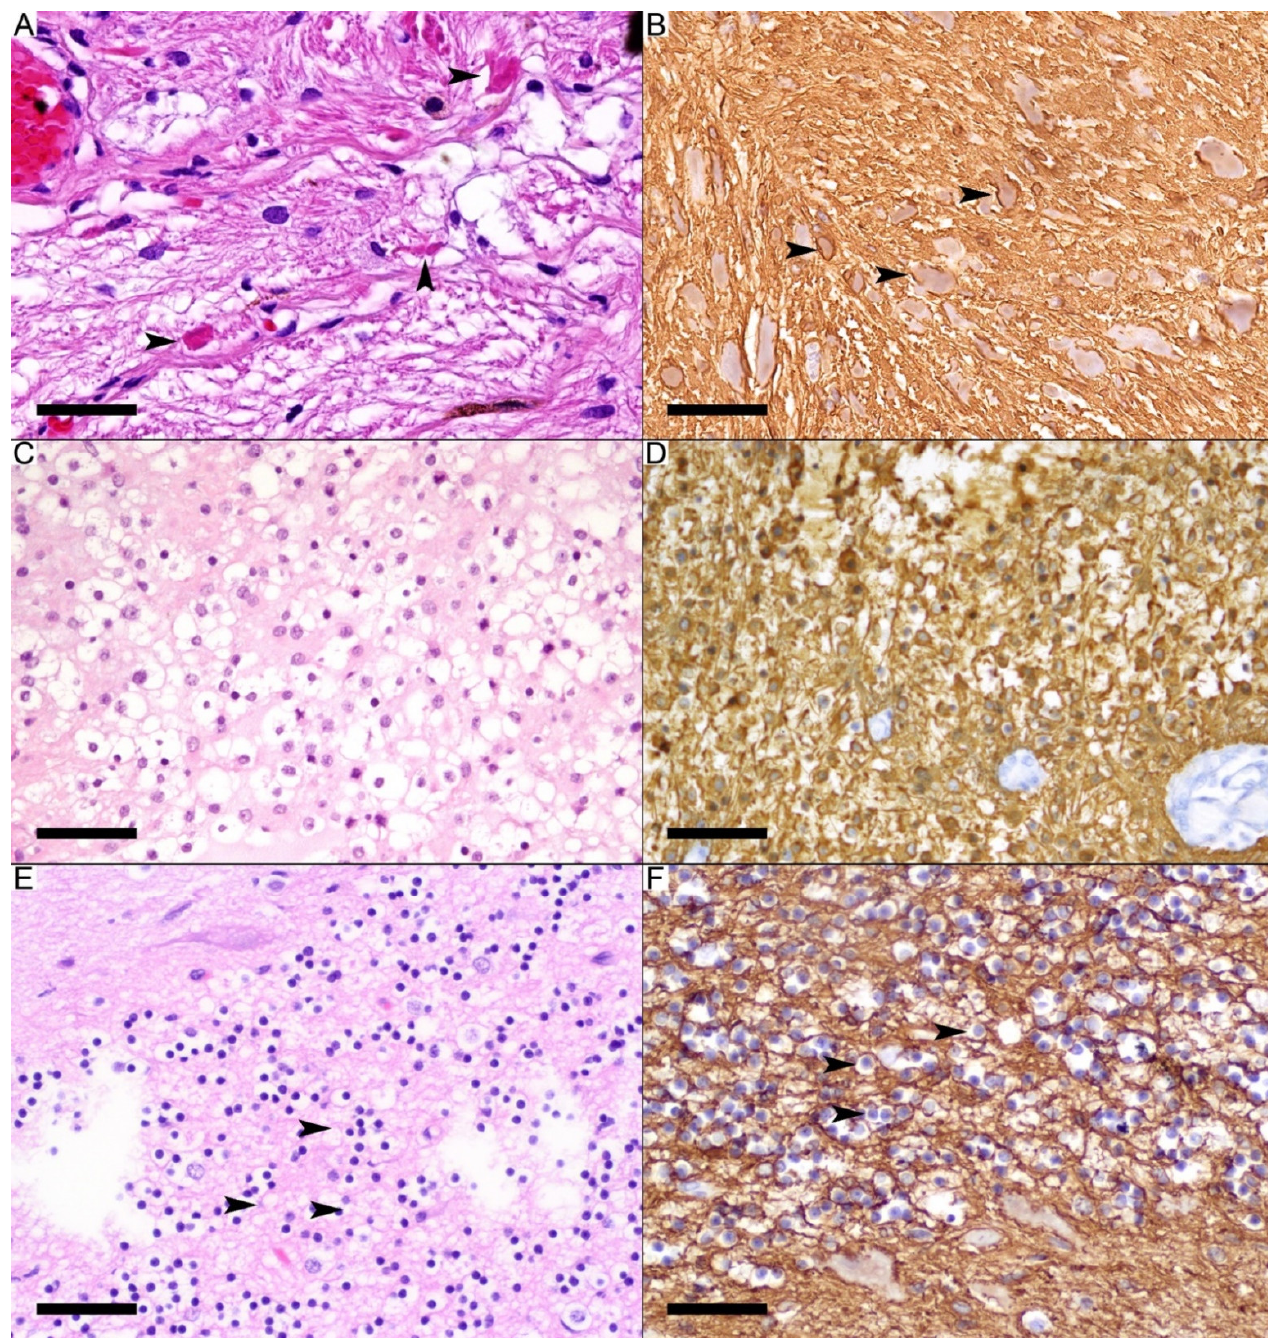
Figure 2. GFAP staining in pilocytic astrocytoma. ( A ) Solid fibrillary area in pilocytic astrocytoma with Rosenthal fibers (arrowheads). ( B ) Diffuse and strong GFAP immunostaining in the elongated neoplastic cells. The Rosenthal fibers are within the astrocytic processes (arrowheads). ( C ) Microcystic area with oligodendrocyte-like neoplastic cells. ( D ) Diffuse and strong GFAP immunostaining (score 4) in the round cells. The immunostaining is mainly a cytoplasmic rim around the nucleus with no processes. ( E ) The granular cell layer of the cerebellum appears as round blue cells with perinuclear clearing (arrowheads). ( F ) GFAP staining in the granular cell layer highlights background staining, whereas the round cells are immunonegative for the GFAP immunostain (arrowheads). Scale bars: 50 µm ( A – F ).